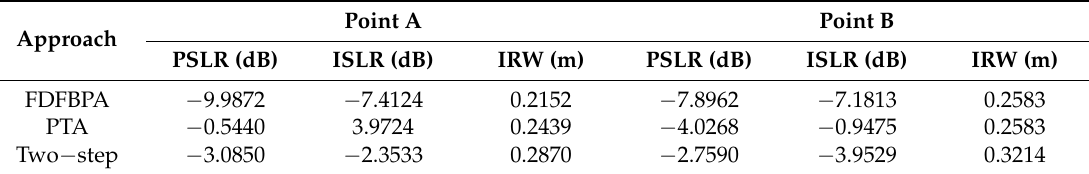
Figure 12. Azimuth pulse response curve comparison of FDFBPA, PTA and Two-step MOCO: ( a ) Scatter Point A; ( b ) Scatter Point B. Table 4. Comparison of Quantification Statistics Results.